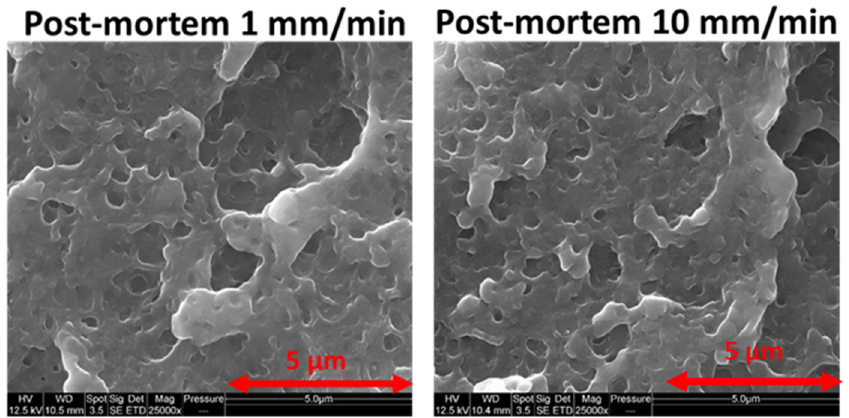
Figure 11. Comparison of cavitation phenomena within ABS and PP—SEM pictures on cryofrac- tured dogbones and post-mortem samples from tensile tests at 10 mm/min.